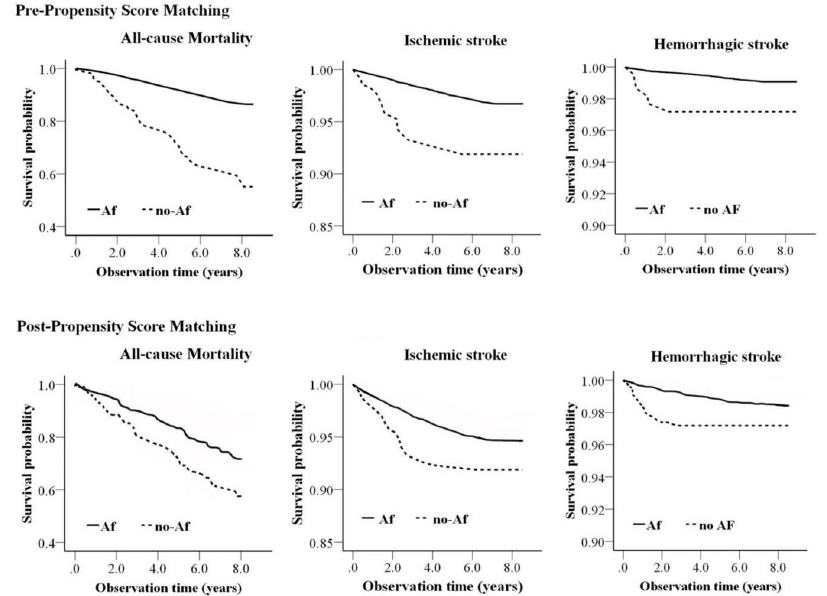
Fig 2. Kaplan-Meier Curve demonstrating the association of AF with all-cause mortality and stroke events among pre- and post-propensity score-matched participants.